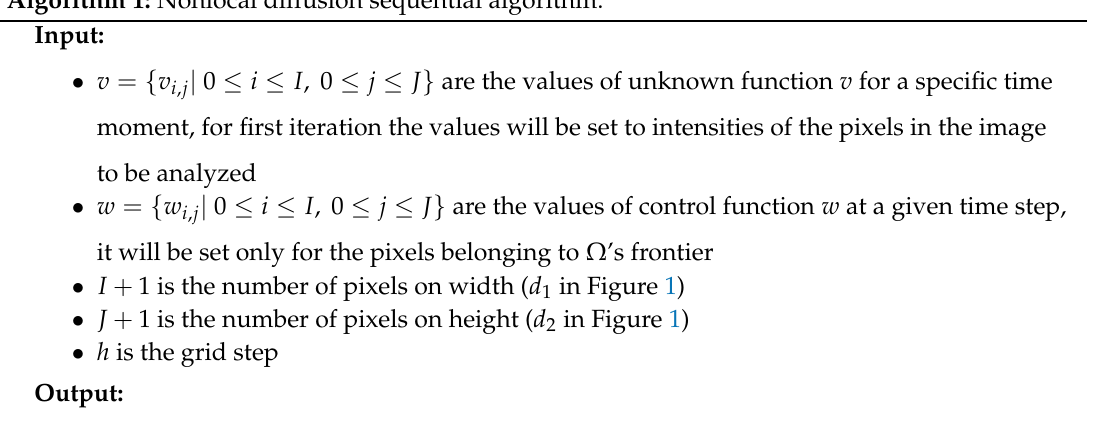
Algorithm 1: Nonlocal diffusion sequential